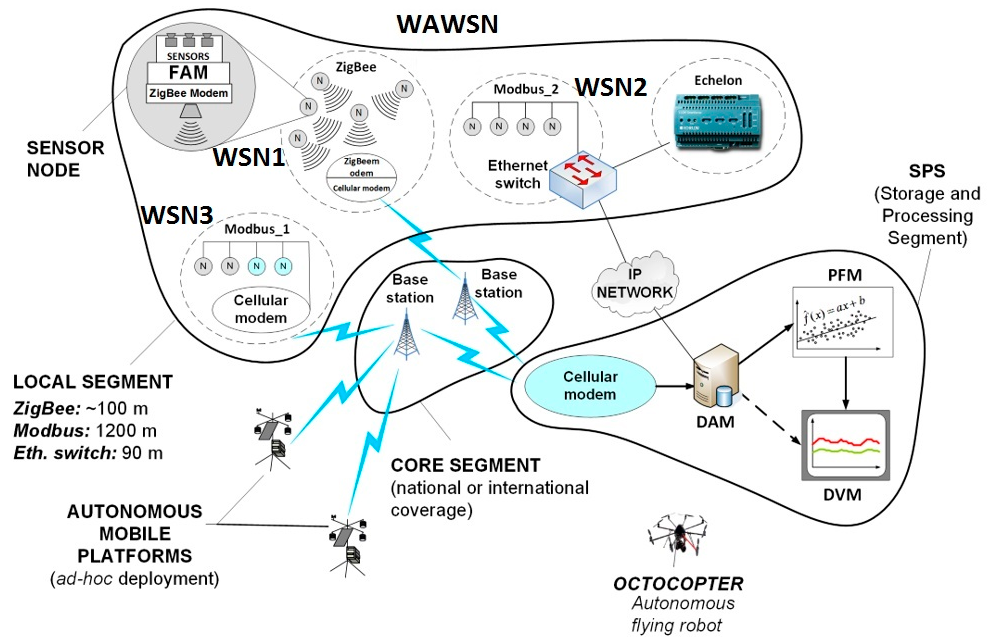
Figure 1. A block architecture of a wide-area sensor communication system.